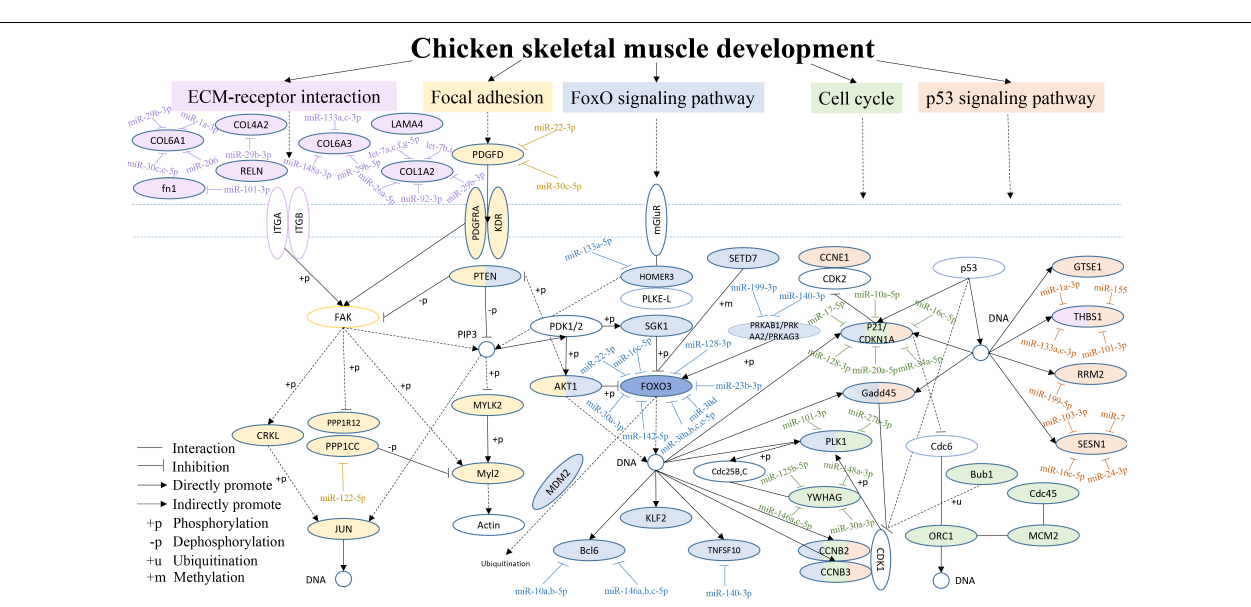
FIGURE 5 | An interaction network of the DEGs and DEMs across five pathways during chicken breast muscle development. The genes within the ECM-receptor interaction, focal adhesion, FoxO signaling, cell cycle and p53 signaling pathways are shown in fuchsia, yellow, purple, green, and orange–red, respectively. The genes along with different pathways are shown in different combined colors. The genes with colors and target miRNAs are differentially expressed genes or miRNAs identified in the study ( p < 0.05). The genes without color were not in our differentially expressed data and are shown as a supplement.